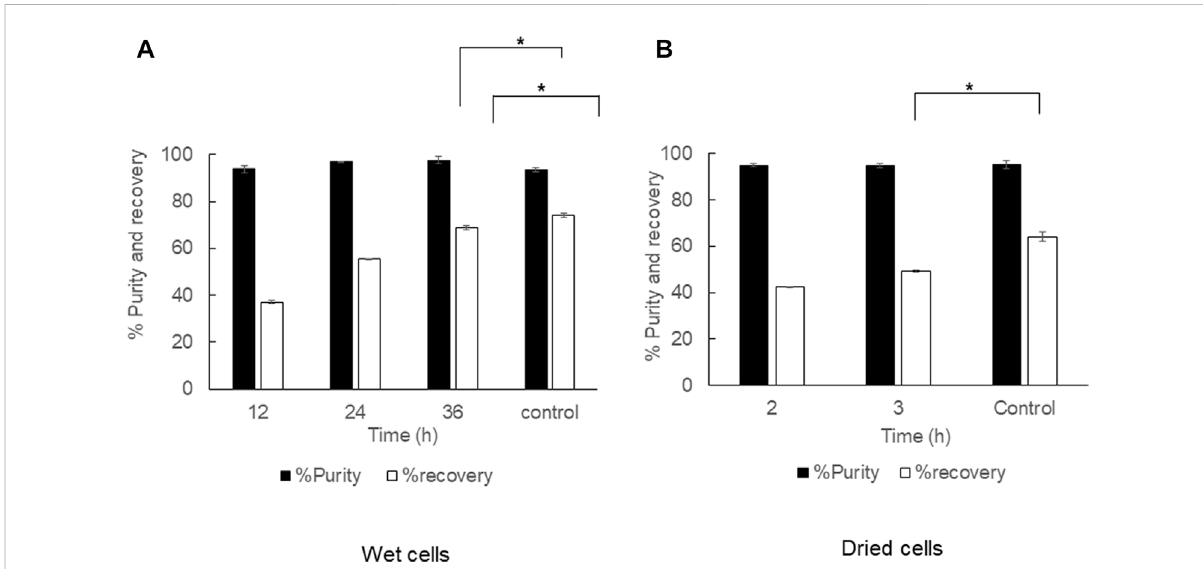
FIGURE 8 Time courses of PHB extraction from cell rupture by steam explosion prior to 1,3-dioxolane extraction. (A) Wet cells at 150 rpm under room temperature and (B) dried cells at 150 rpm under 80 ° C. All the data are representative of the results of three independent experiments and are expressed as the mean values ± standard deviations (SDs). The asterisk indicates a signi fi cant difference ( p <